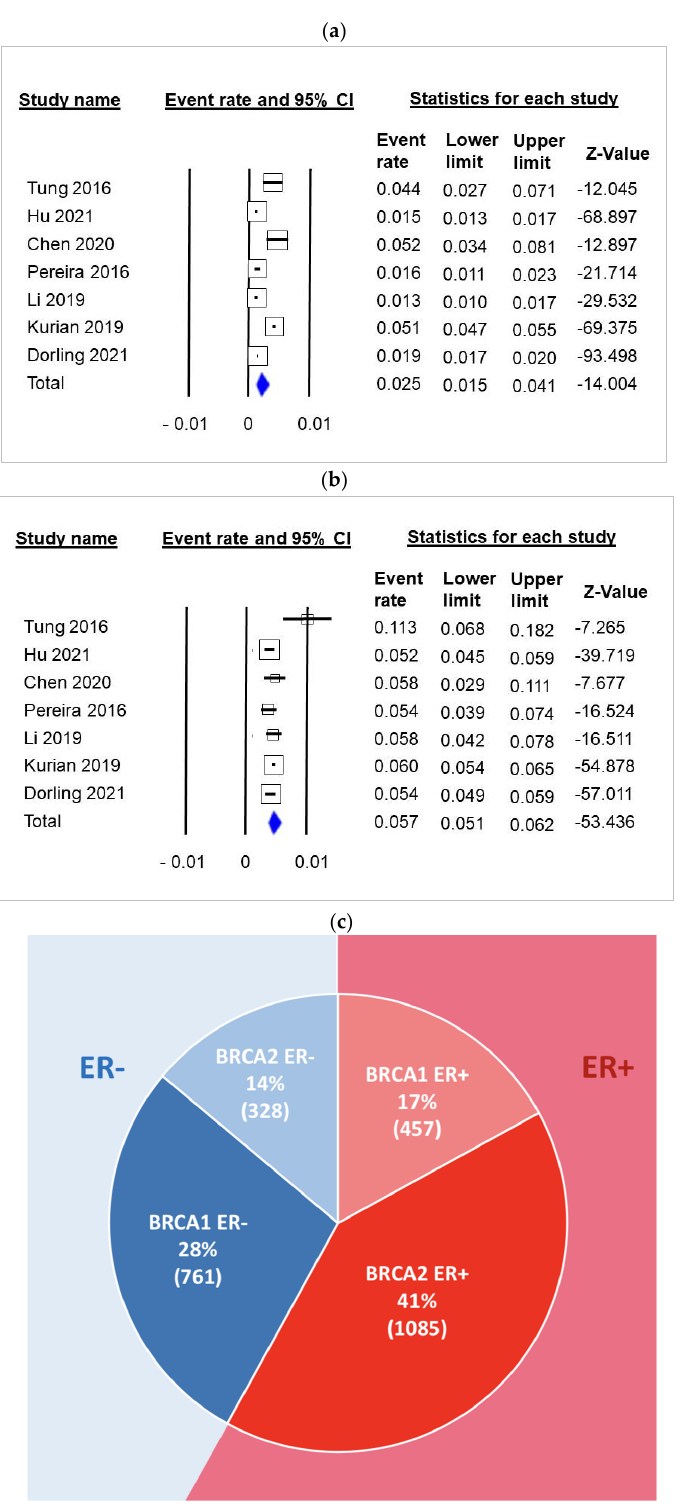
Figure 2. Meta-analysis of gBRCA1 and gBRCA2 among unselected breast cancer patients by estrogen receptor (ER) status. ( a ) gBRCA carriers among ER+ unselected breast cancer patients; ( b ) gBRCA carriers among ER- unselected breast cancer patients; ( c ) Frequency of ER+ and ER- tumors among unselected breast cancer patients with gBRCA. Legend: n of tumors are in bracket. The total number of breast cancer cases analyzed was 86,670.